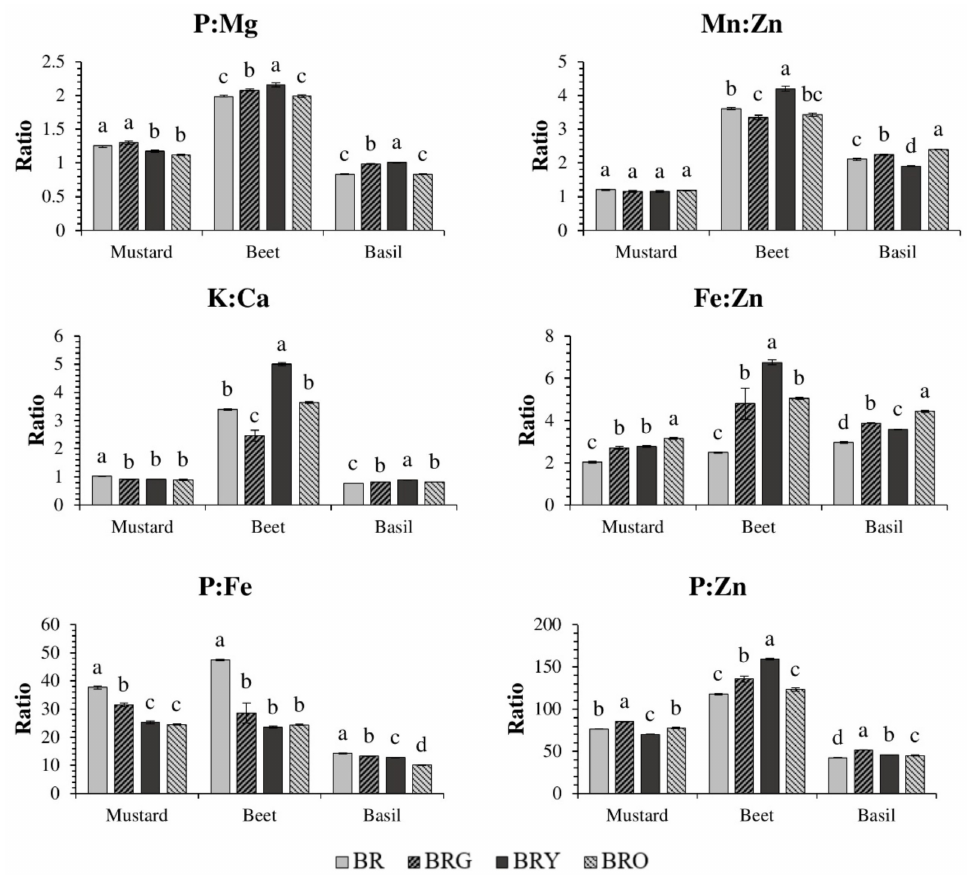
Figure 2. Ratios between mineral nutrients in mustard, beet, and basil microgreens. BR—blue (peak = 447 nm), red (peak = 638 and 665 nm), far-red (peak = 731 nm); BRG—BR with green (peak = 520 nm); BRY—BR with yellow (peak = 595 nm); BRO—BR with orange (peak = 622 nm). Total PFD was maintained at 300 µ mol m − 1 s − 2 , changing the input of red (peak = 638 nm). Means with different letters are significantly different at the p < 0.01 level by Tukey’s honestly significant difference test. Error bars show